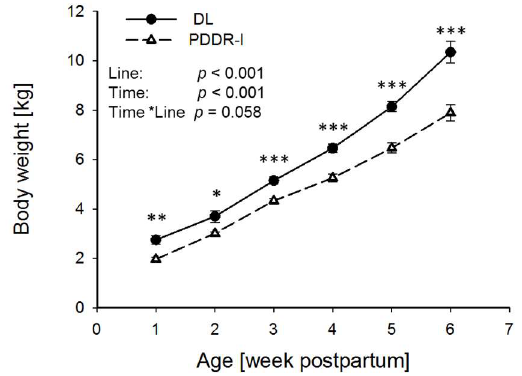
Figure 2. Growth curve of DL ( n = 8) and PDDR-I piglets ( n = 7) from week 1 p.p. to week 6 p.p. Data are presented as means ± SEM; * p < 0.05, ** p < 0.01. *** p < 0.001.